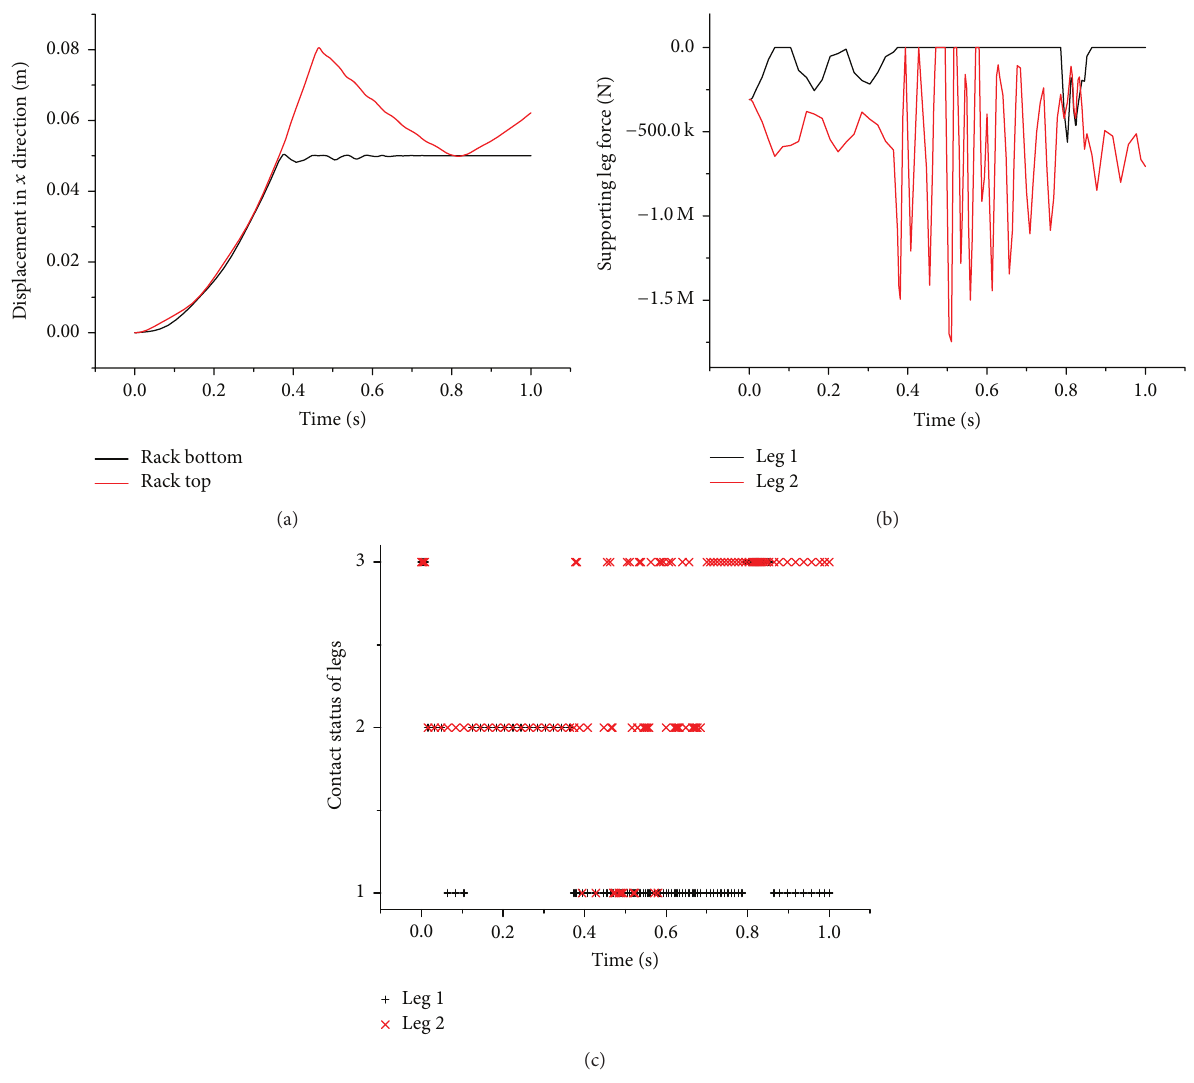
Figure 8: Uniform acceleration amplitude loading: